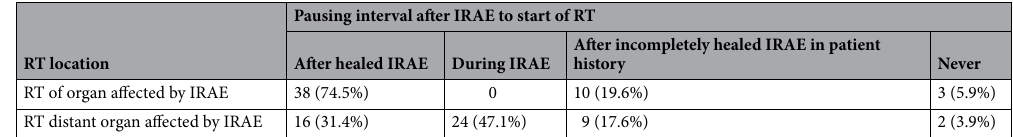
After incompletely healed IRAE in patient history Never